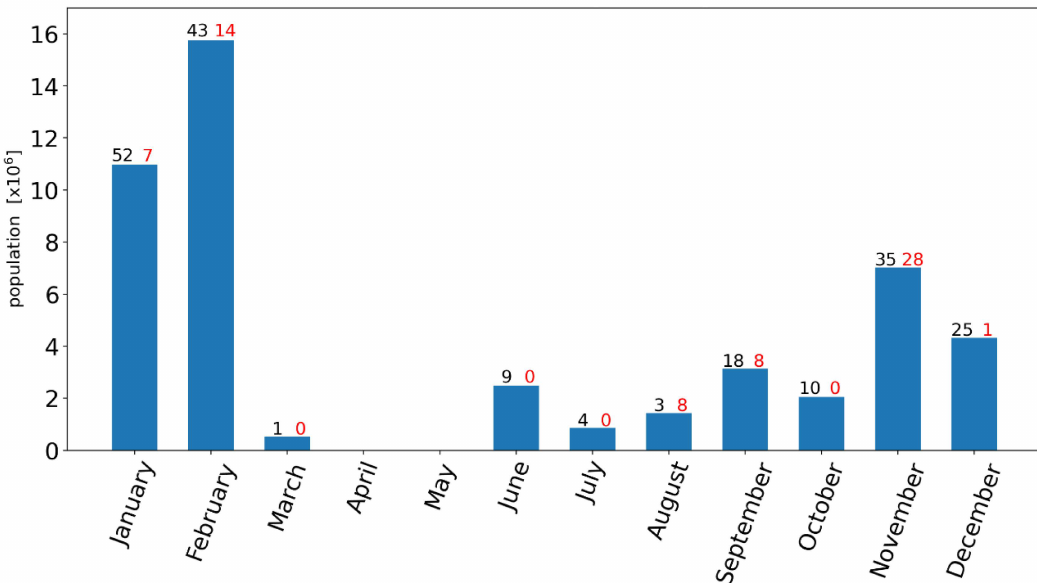
Figure 3. Total population affected by named storms in Greece per month January 2017 and September 2021. Black numbers on the top of the bars denote the number of prefectures affected by the storms for each month and the red numbers show the total number of fatalities for each